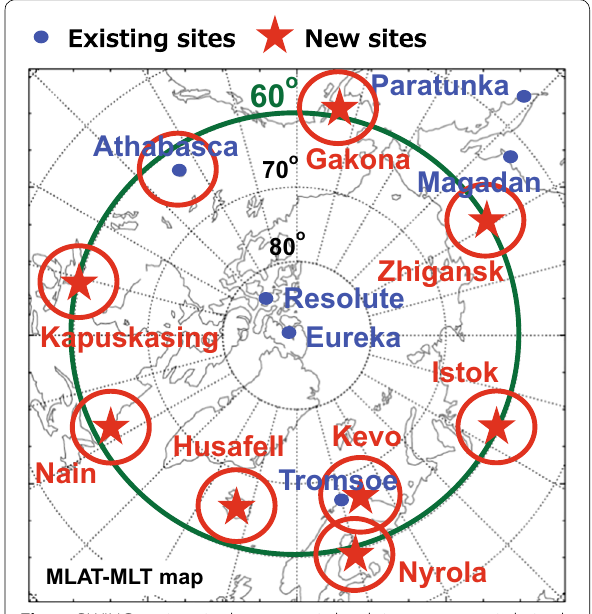
Fig. 1 PWING stations in the magnetic local time—magnetic latitude map. Blue dots and red stars indicate preexisting and new sites deployed by the PWING project, respectively. The red circles indicate rough area of the field of view of all‑sky